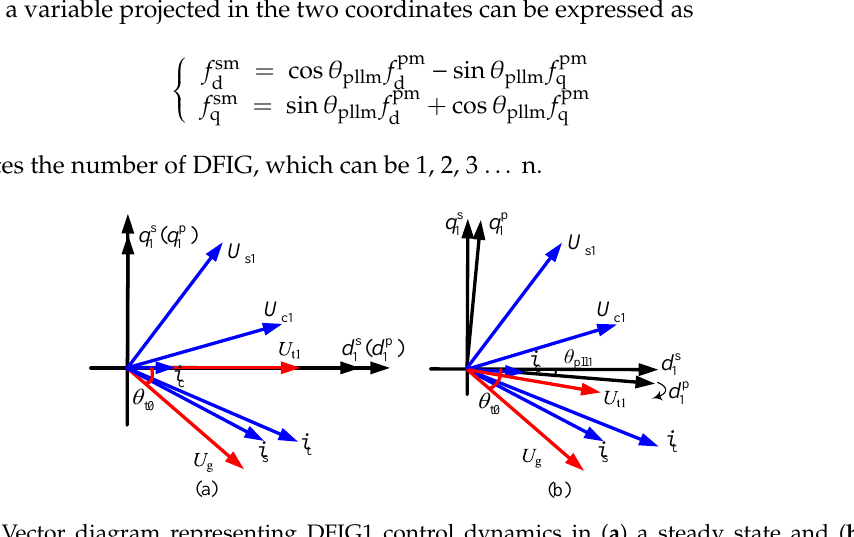
Figure 3. Vector diagram representing DFIG1 control dynamics in ( a ) a steady state and ( b ) a dynamic process.